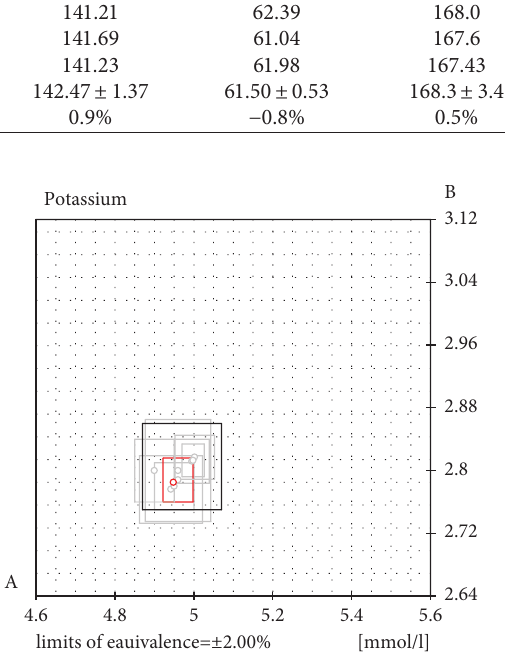
Figure 3: Result of RELA